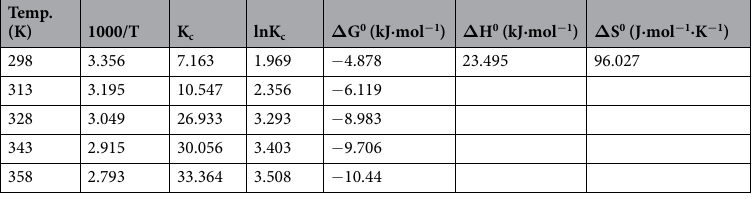
Table 4. Thermodynamic parameters for oil sorption onto nano-magnetic activaited